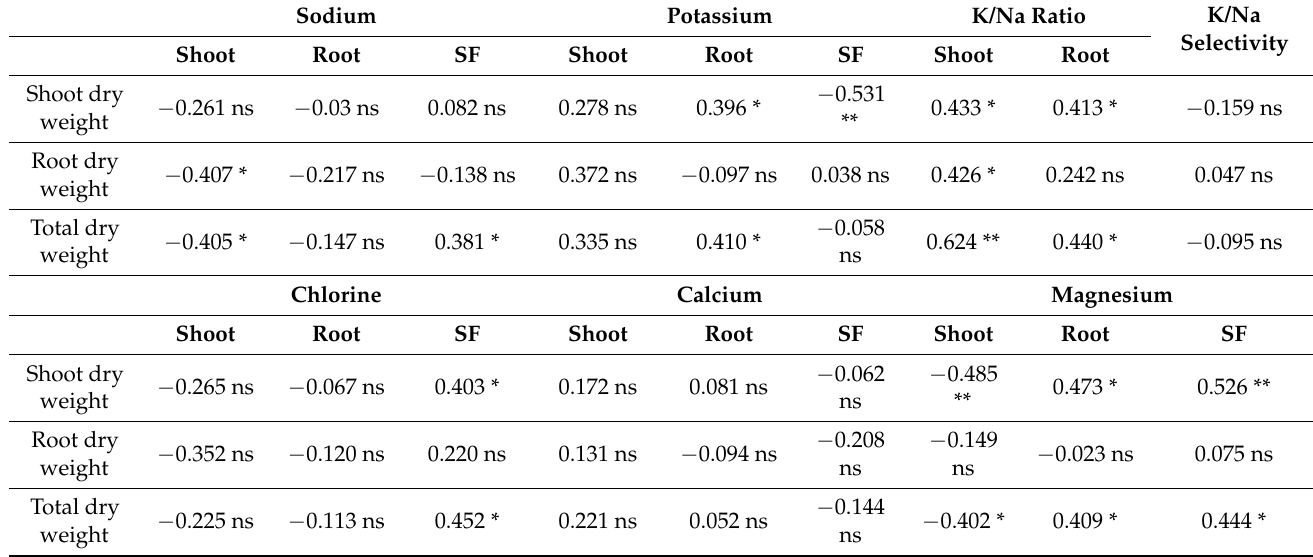
Table 4. Correlation of dry weight with ions accumulation and distribution.